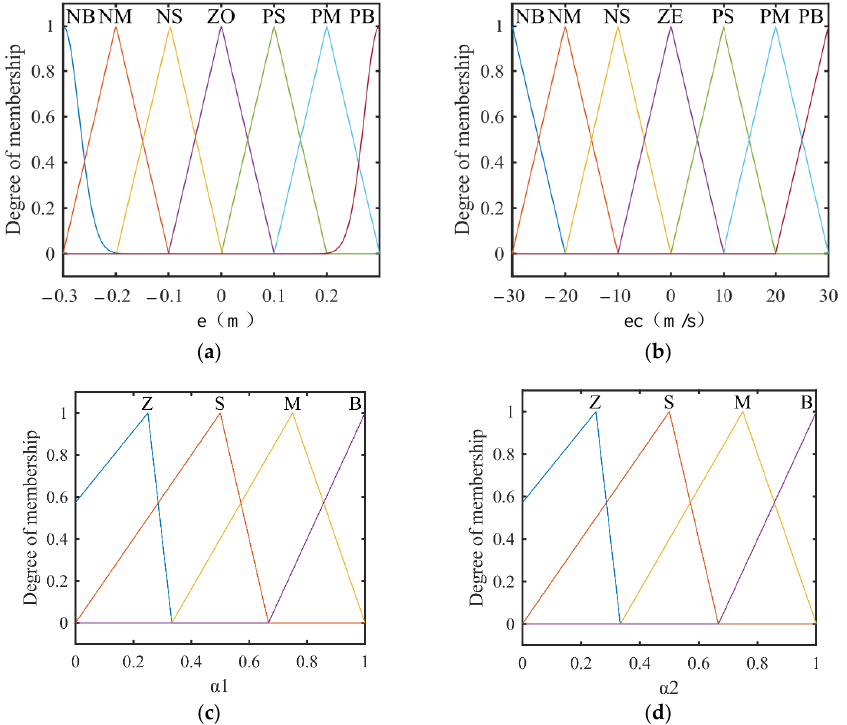
Figure 11. Membership function of input and output variables of the fuzzy controller II. ( a ) Membership function of E. ( b ) Membership function of EC. ( c ) Membership function of α 1 . ( d ) Membership function of α 2